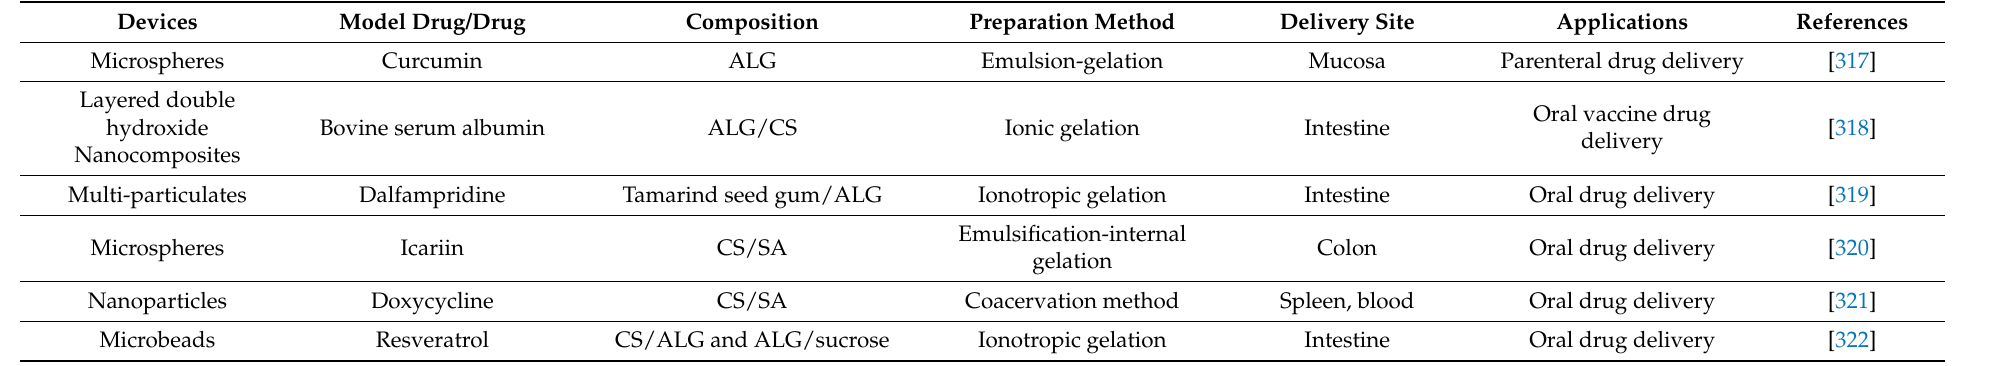
Table 3. Current approaches in ALG preparation for enhanced drug